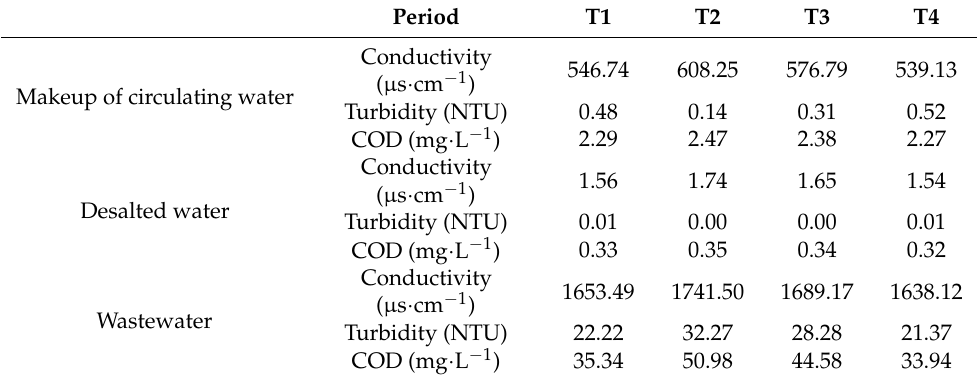
Table 8. Water property of water sinks after optimization (Scenario 3).